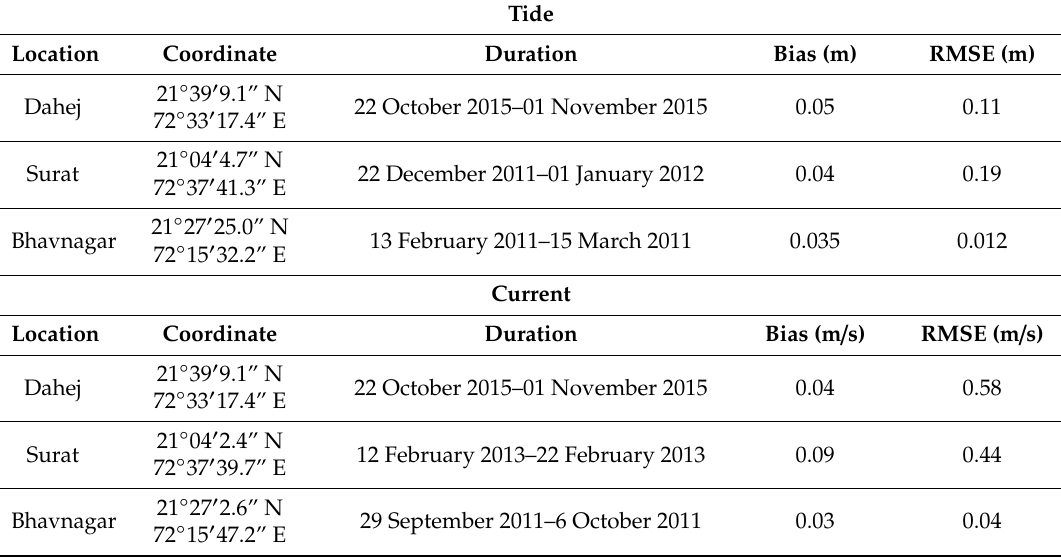
Figure 4. Comparison of observed and predicted current speed at three locations of GoK; ( a ) Surat, ( b ) Dahej, and ( c ) Bhavnagar. The location details, along with comparison statistics, are presented in Table 1. Table 1. Details of data used for calibration of tide and